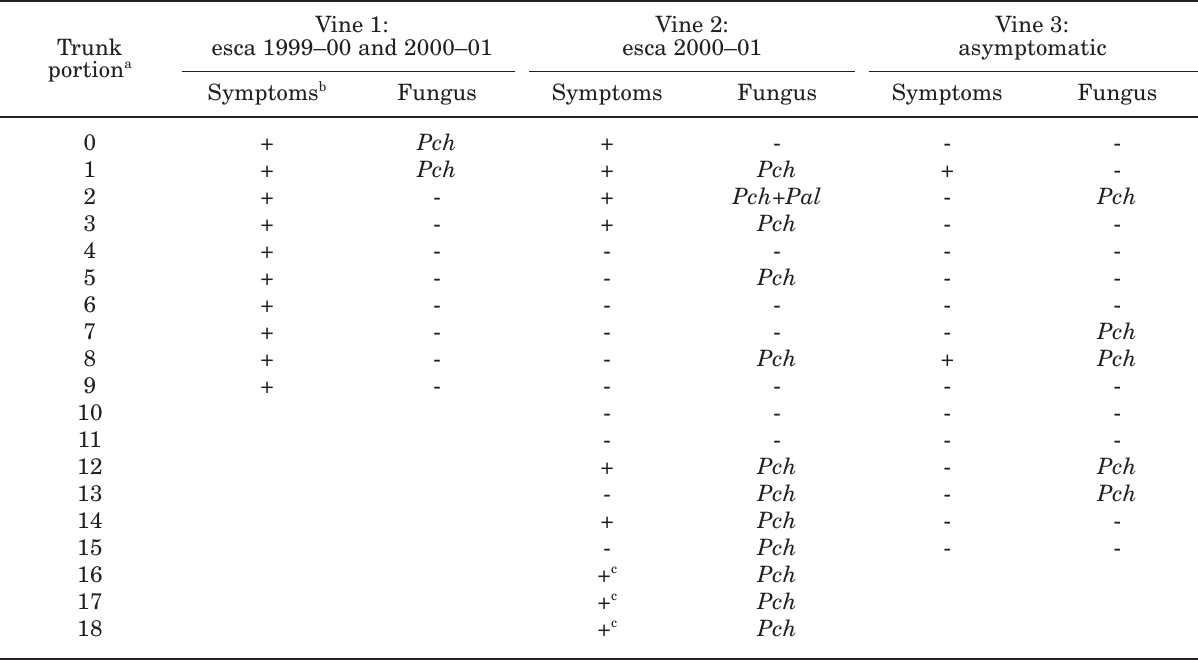
Table 1. Internal symptoms and esca-associated fungi ( Phaeomoniella chlamydospora, Pch; Phaeoacremonium aleo- philum, Pal ) found in the trunks of 7-year-old own-rooted Shiraz vines from site 1, Waikerie, South Australia,